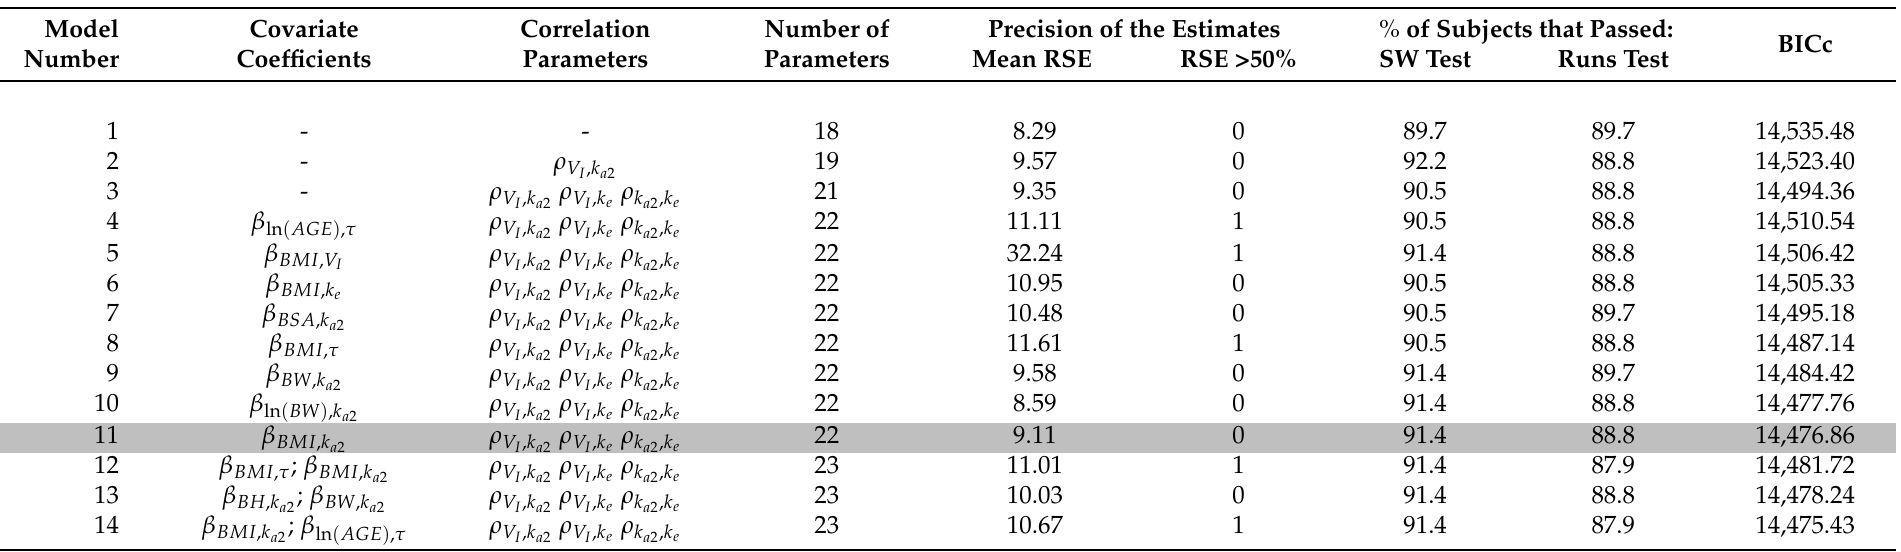
Table 1. Summary of the tested models of the parameter variability, ordered by ascending number of parameters. From left to right: model number; the additional parameter β k , i used to introduce the covariate c k in the variability model of ψ i ; the additional parameter ρ i estimate precision expressed as the mean RSE and the number of parameters showing RSE > 50%; percentages of the subjects that passed the Shapiro–Wilk (SW) test and the runs test; the value of the BICc. The selected model is highlighted in